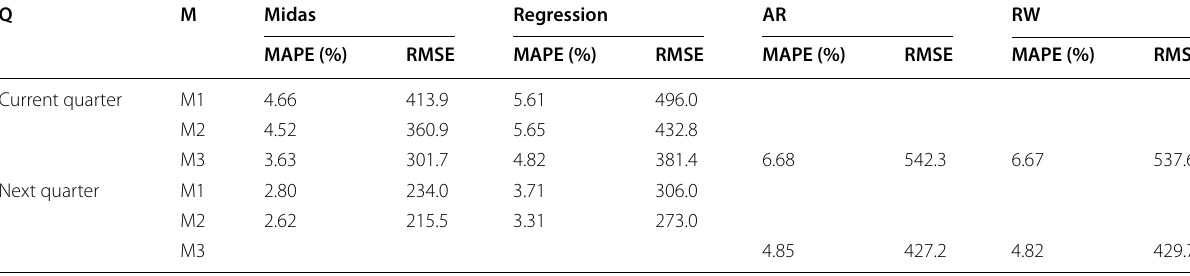
Table 9 MAPE and RMSE loss functions for export of goods models (in nominal values) Q M